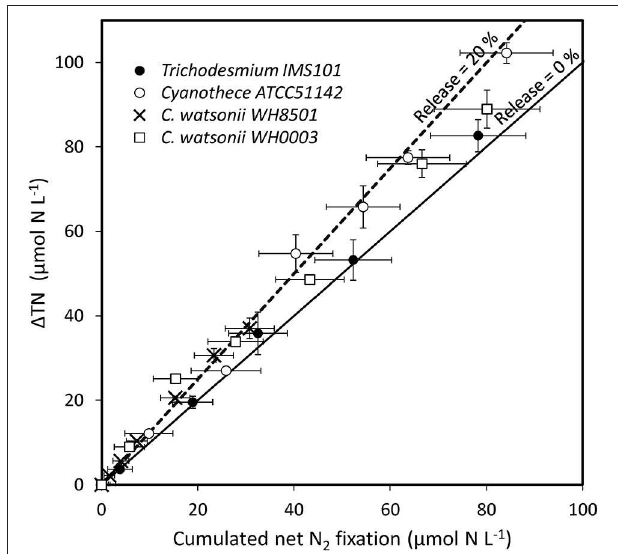
FIGURE 3 | TN accumulation ( 1 TN), accounting for gross N 2 fixation, as a function of cumulated incorporation of N 2 in the PON, accounting for net N 2 fixation, in the culture media during exp 1. Error bars represent the standard deviation of triplicate measurements and the propagated analytical error. The lines show the evolution of the system assuming a proportion of fixed N 2 released as DN accounting for 0% (solid line) and 20% (dotted line) of the gross N 2